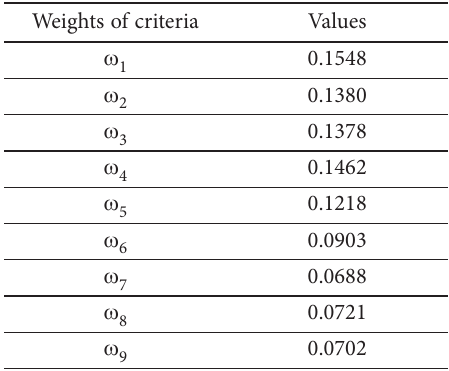
Table 2. The weight vector of